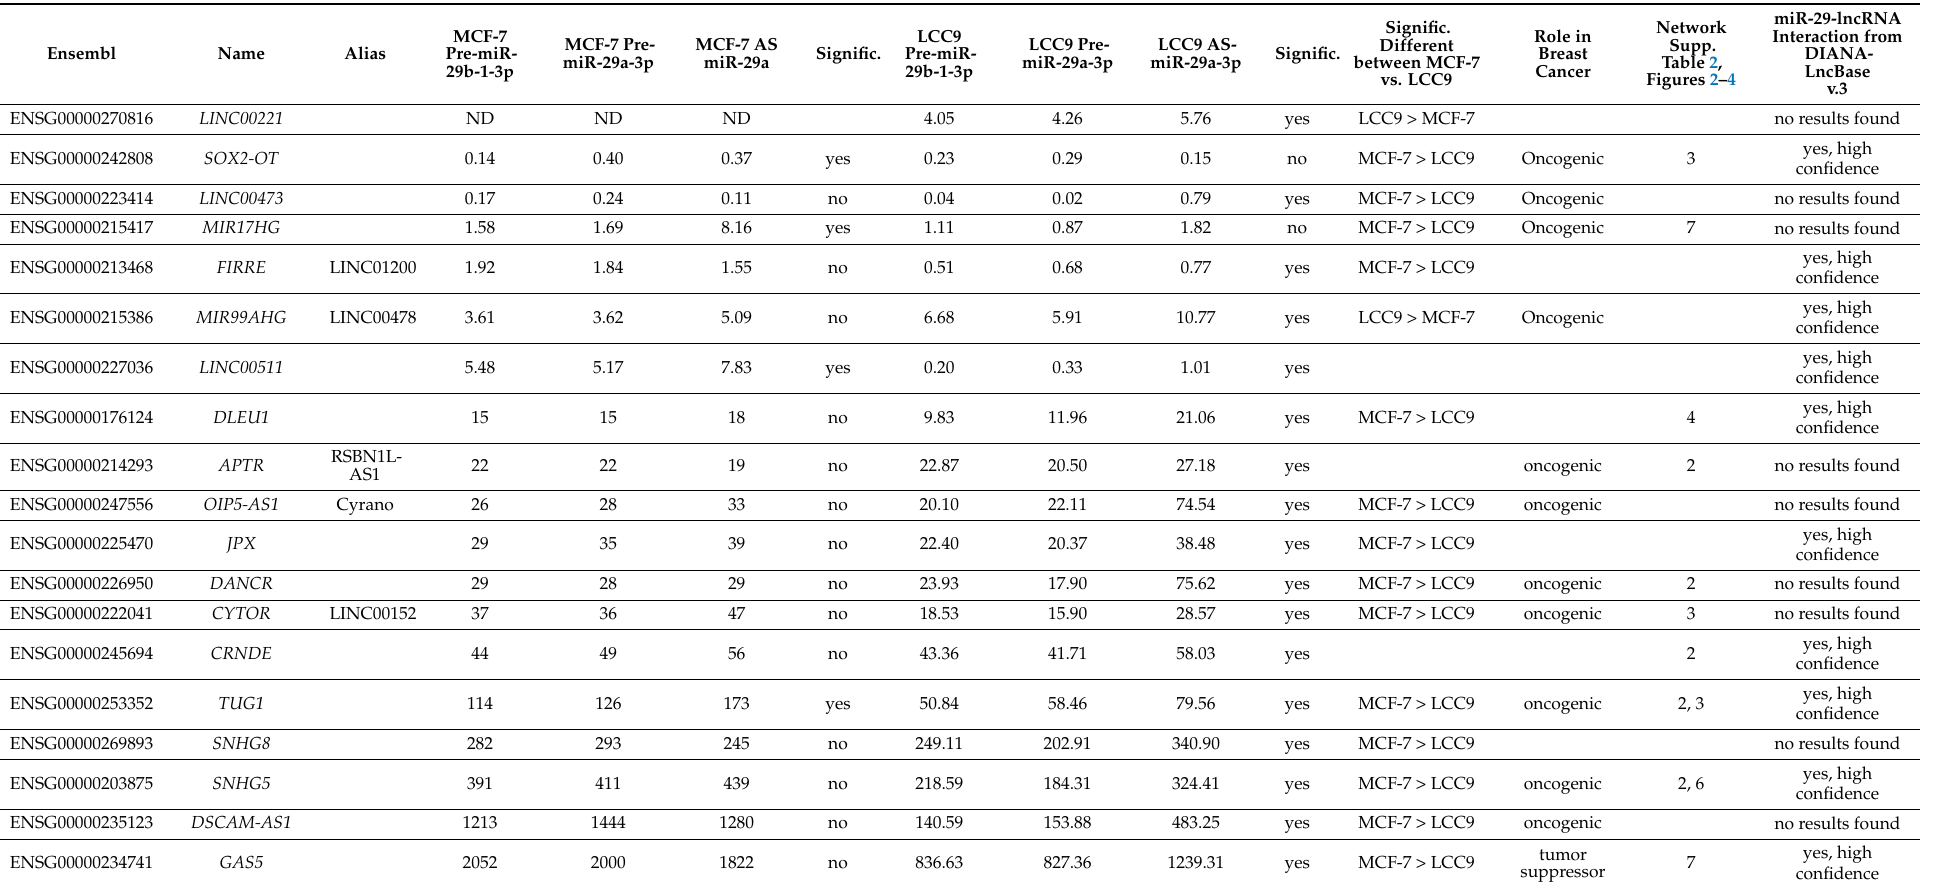
Table 1. lncRNAs downregulated by miR-29b-1/a in MCF-7 and/or LCC9 breast cancer cells. MCF-7 or LCC9 cells were transfected with pre-miR-control, pre-miR-29b-1-3p, pre-mir-29a-3p, anti-miR-29a (which targets miR-29b-1/a), or anti-miR negative control for a 48h prior to RNA isolation and RNA sequencing [35]. Values are fragments per kilobase of transcript per million mapped reads (FPKM) and are the average of five replicate samples (GSE81620). Significance was q ≤ 0.05. ND = not